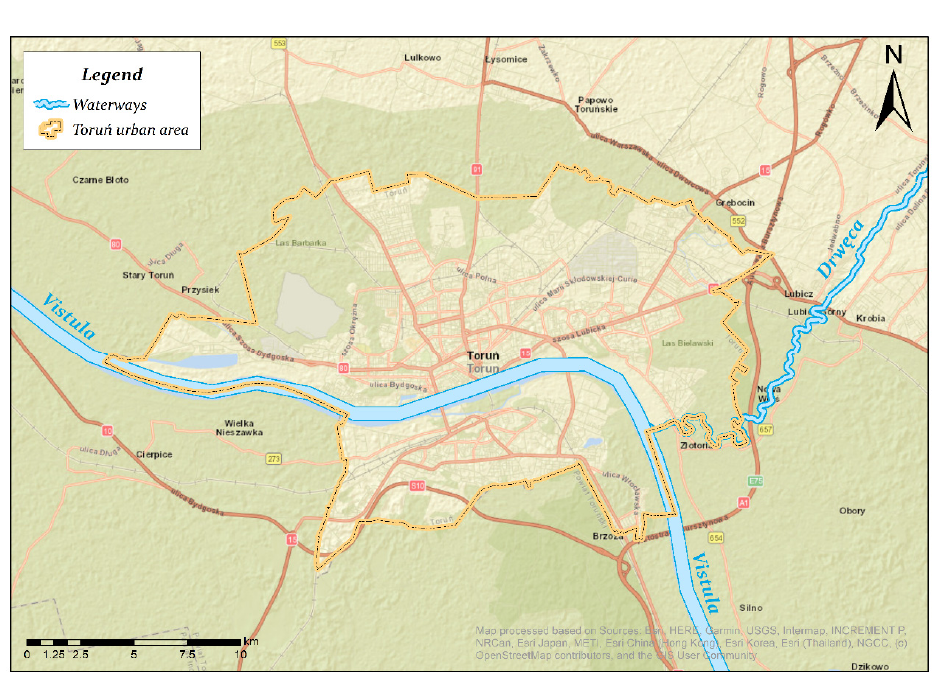
Figure 3. Torun and its Vistula stretch.